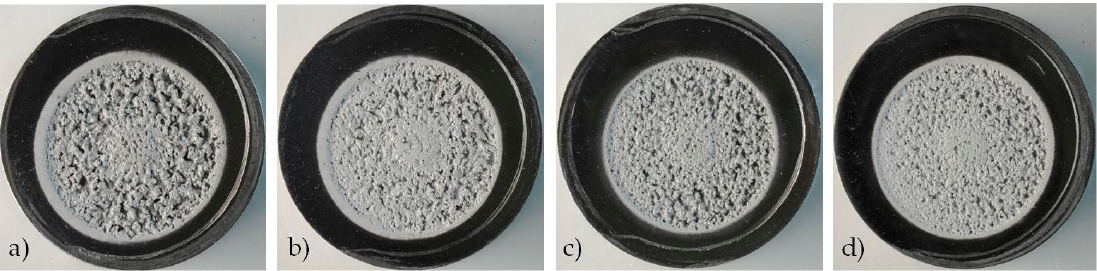
Figure 9. Surface topographies of the damaged areas of NUST as-cast ( a ); NUST after T6 ( b ); UST as-cast ( c ); and UST after T6 ( d ).